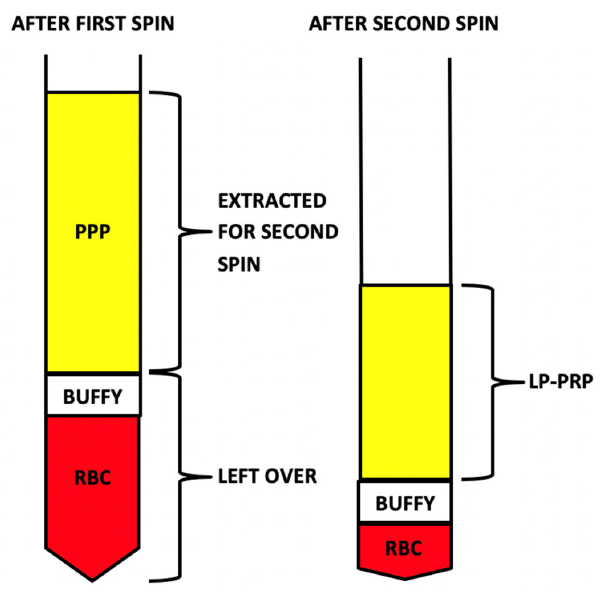
Figure 4. Demonstration of the peripheral blood separation and resulting layers after the first and second centrifugation steps. Leukocyte-poor platelet-rich plasma (LP-PRP); platelet-poor plasma (PPP); red blood cells (RBCs).